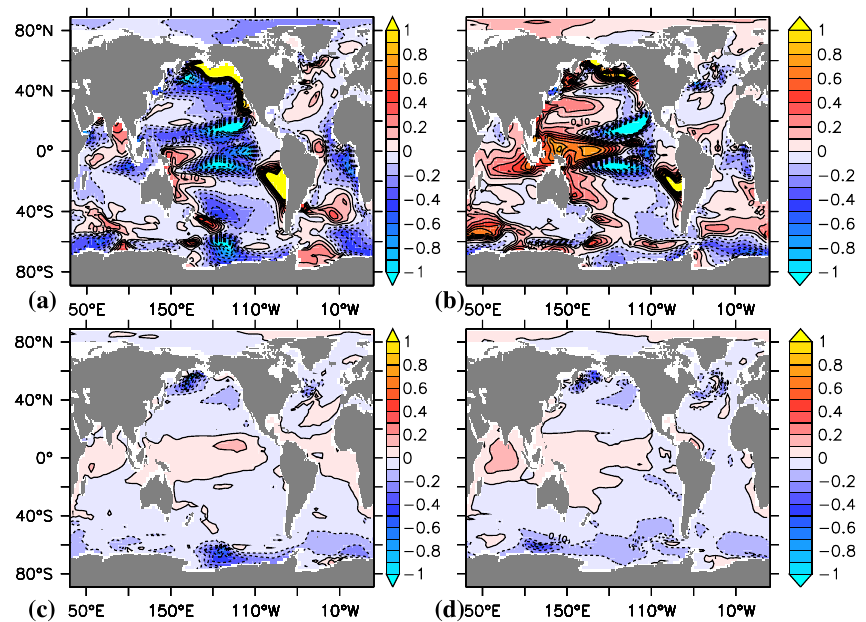
Fig. 8. Simulated linear trend of dissolved oxygen at 300dbar for the period 1960 to 2010 (a) for the experiment CORE-1 switching from NCEP/NCAR climatological to interanually varying CORE winds on 1. January 1958, (b) running the model with 1958–1967 mean CORE forcing from 1765 until the end of 1957 and then switching to interannually varying CORE wind stress fields. DO changes at 300dbar simulated with the climatological NCEP/NCAR wind stress are shown in (c) , and simulated with the CORE 1958–1967 monthly mean wind stress in (d) . Units are in µmolkg − 1 yr − 1 .